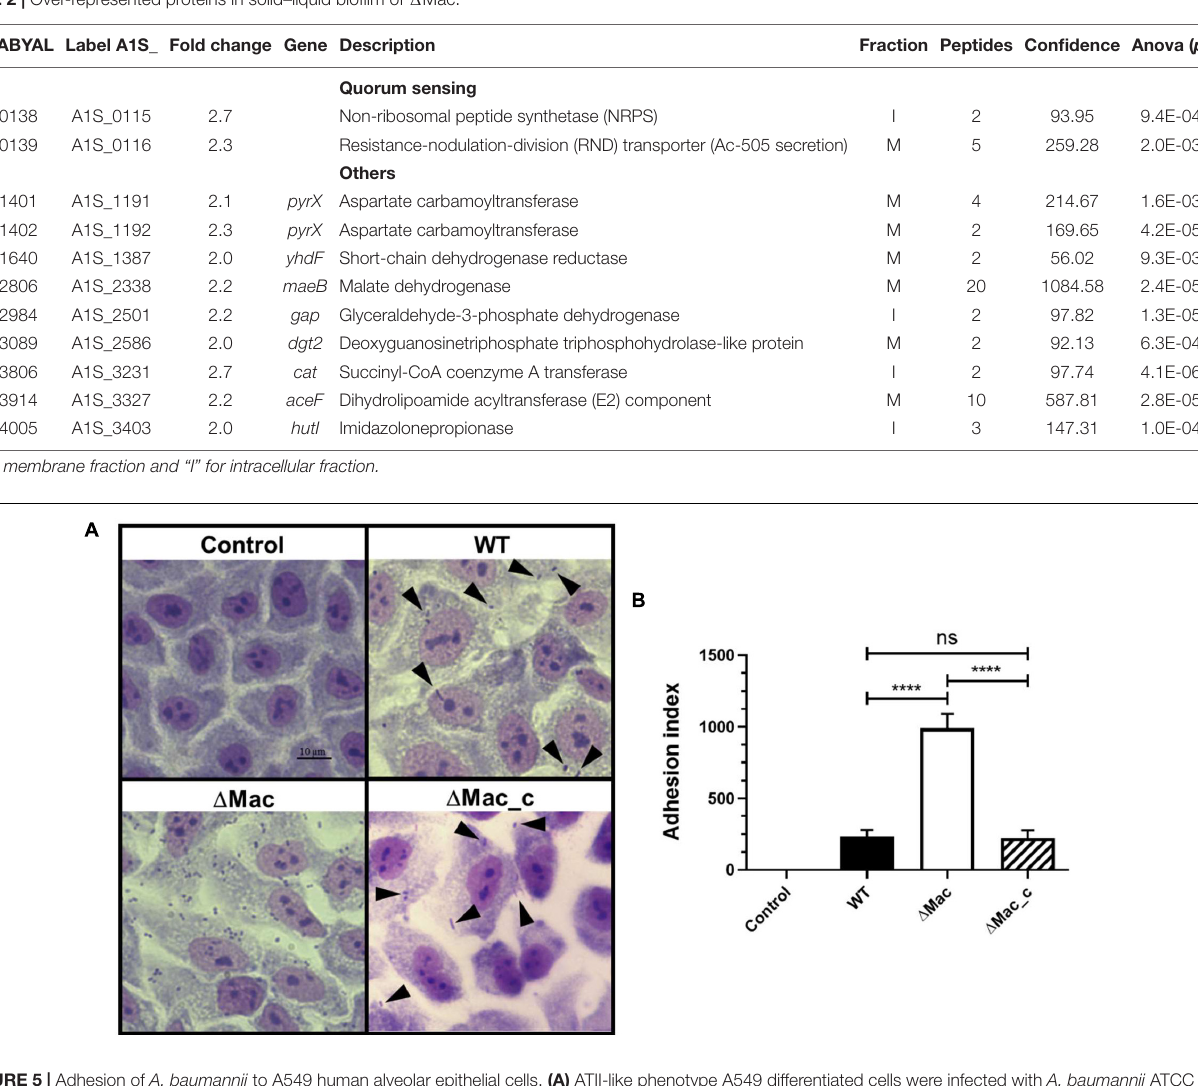
FIGURE 5 | Adhesion of A. baumannii to A549 human alveolar epithelial cells. (A) ATII-like phenotype A549 differentiated cells were infected with A. baumannii ATCC 17978 (WT), (cid:49) Mac, and (cid:49) Mac_c ( (cid:49) Mac complemented) at a multiplicity of infection (MOI) of 20. Negative control corresponds to cells with no bacteria added. Black arrows indicate bacteria attached to A549 cells (magnification, × 400). (B) Quantification of the adherence of A. baumannii ATCC 17978 WT, (cid:49) Mac, and (cid:49) Mac_c strains to A549 cells. Index of attached bacteria after 24 h of infection. Data shown represent mean values ( ± SD) from at least three